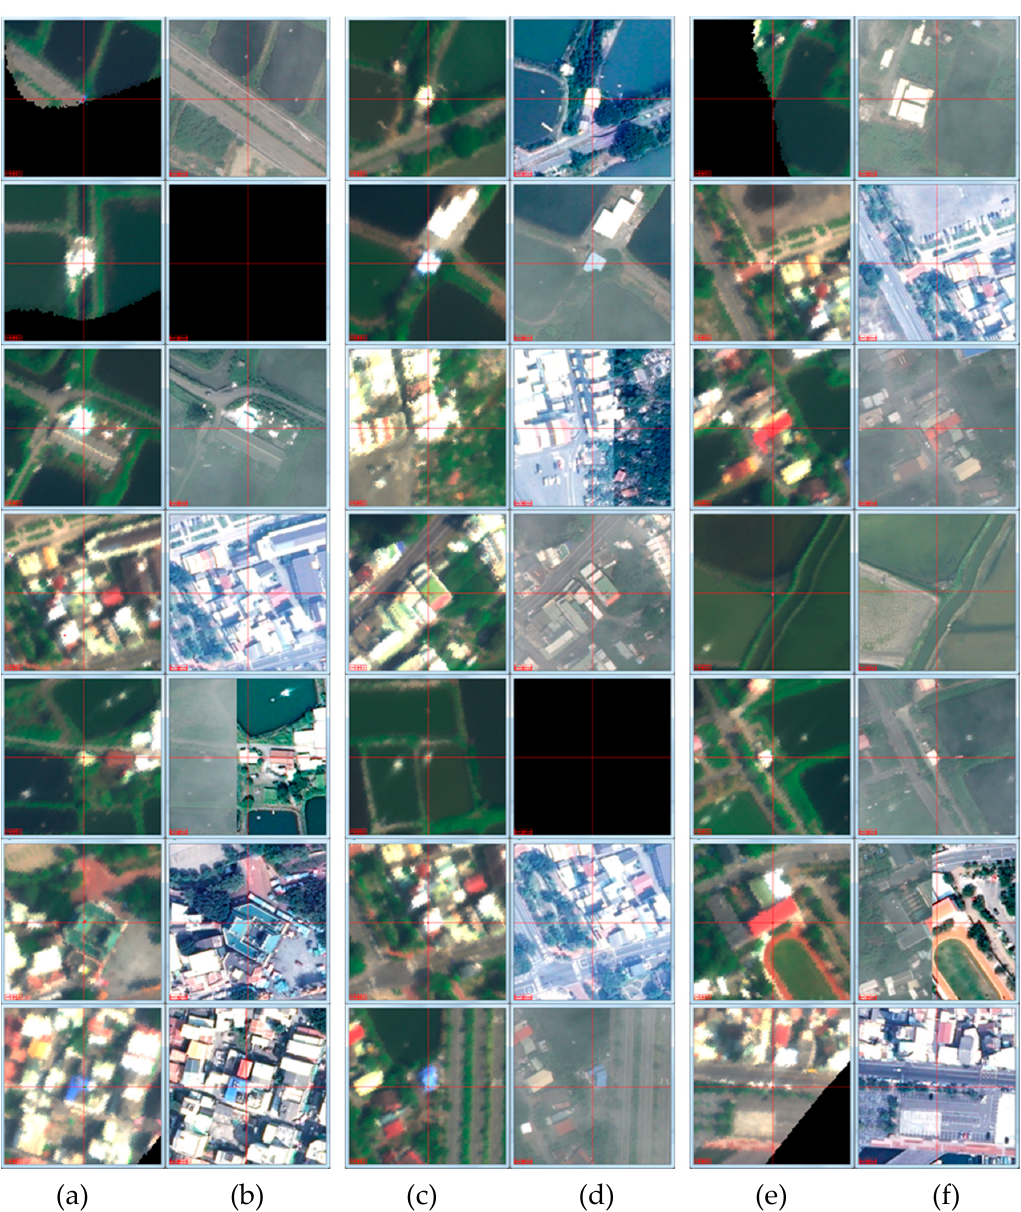
Figure 10. The comparison of the CASI image (a, c, e) and the aerial orthophotograph (b, d, f) for the 21 endmembers retrieved from the MNF-inversed full strip image.